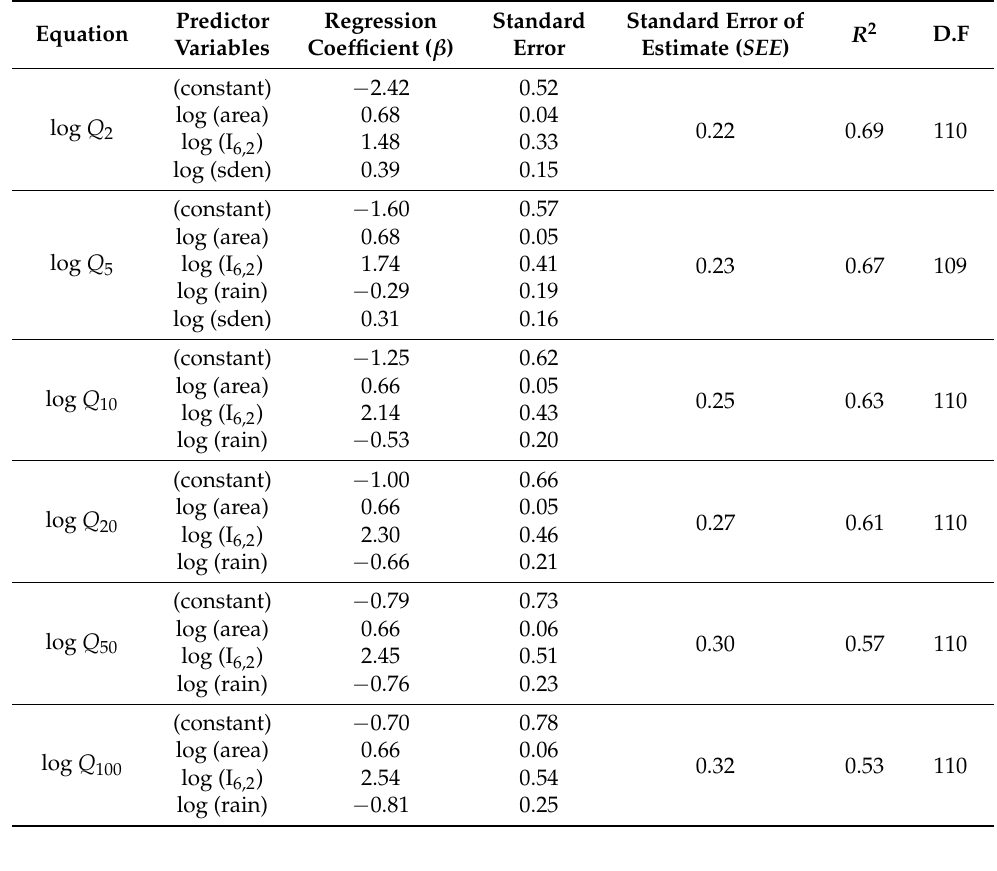
Table 2. Model statistics for log-log linear model of combined group.